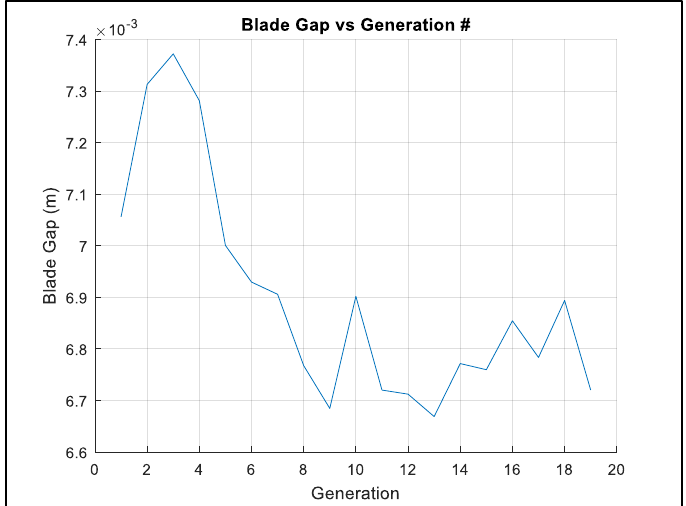
Figure 19. Elite member blade distance against the generation number.